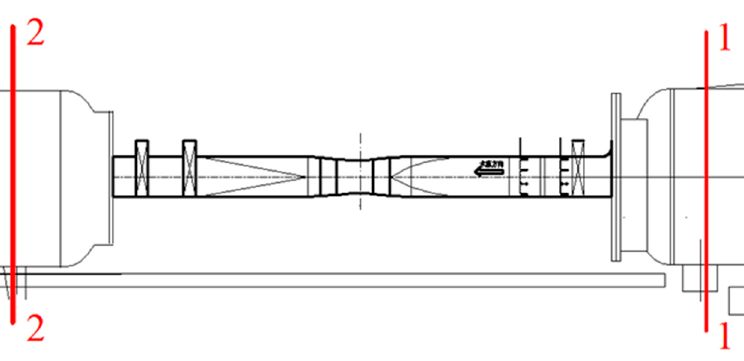
Figure 5. Pressure measuring